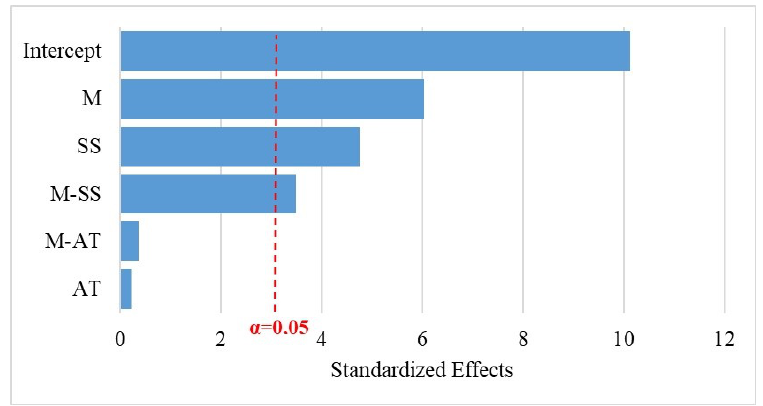
Figure 6. Standardized Pareto Chart for for Izod impact